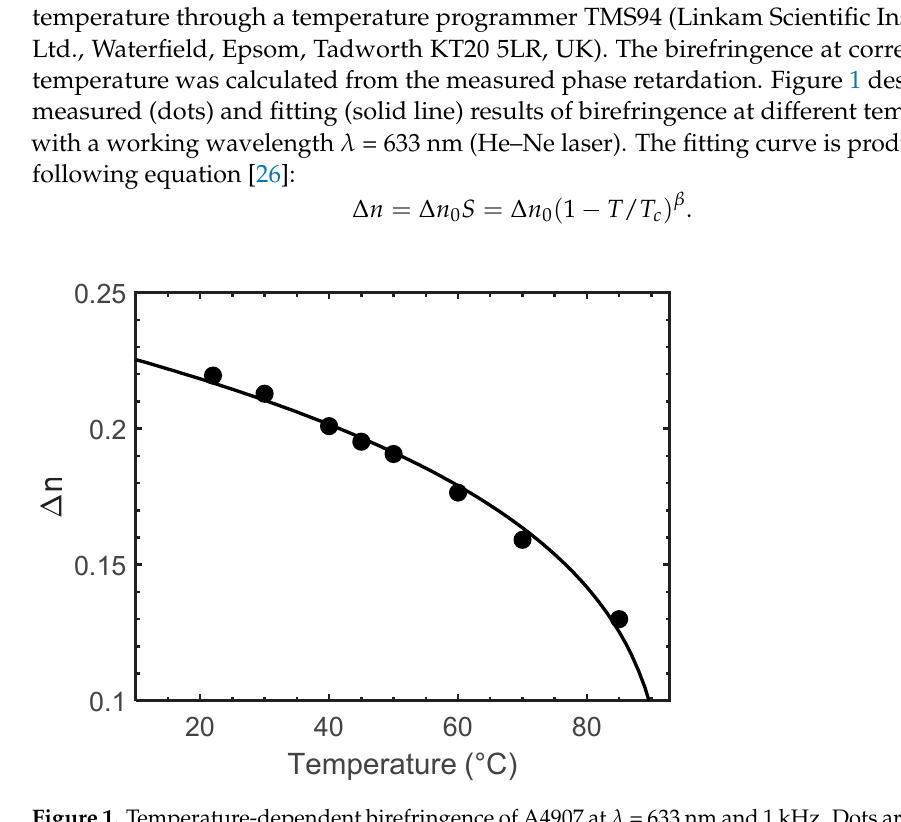
Figure 1. Temperature-dependent birefringence of A4907 at λ = 633 nm and 1 kHz. Dots are measured data and solid line is fitting curve with Equation (1).